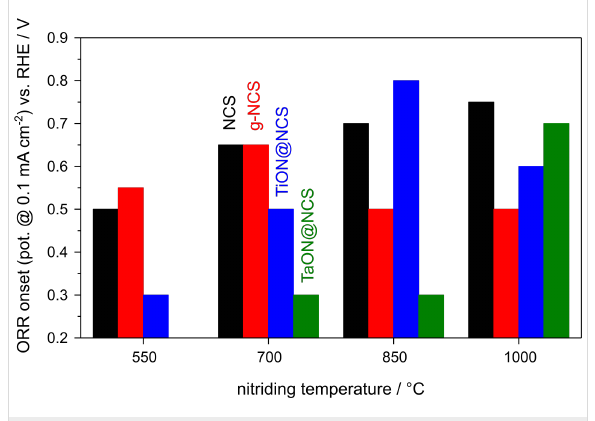
Figure 10: ORR onset potential (potential value at 0.1 mA·cm − 2 ) as a function of the nitriding temperature of NCS, g-NCS, TiON@NCS [33] and TaON@NCS